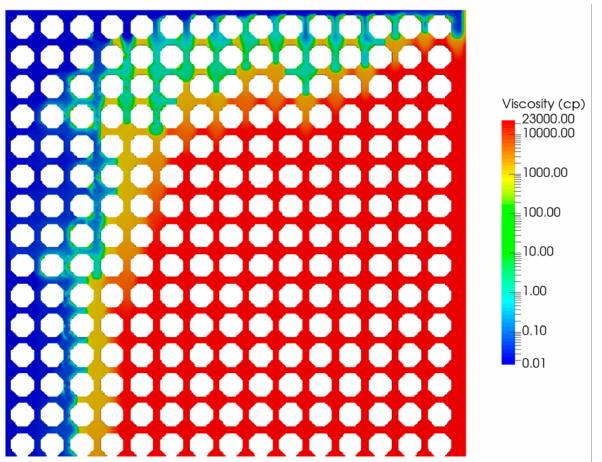
Figure 7. Viscosity distribution in porous media. The solvent viscosity differs in the range of 23,000 cp (red) for pure bitumen to 0.015 cp (blue) for pure solvent. The legend is in logarithmic scale.